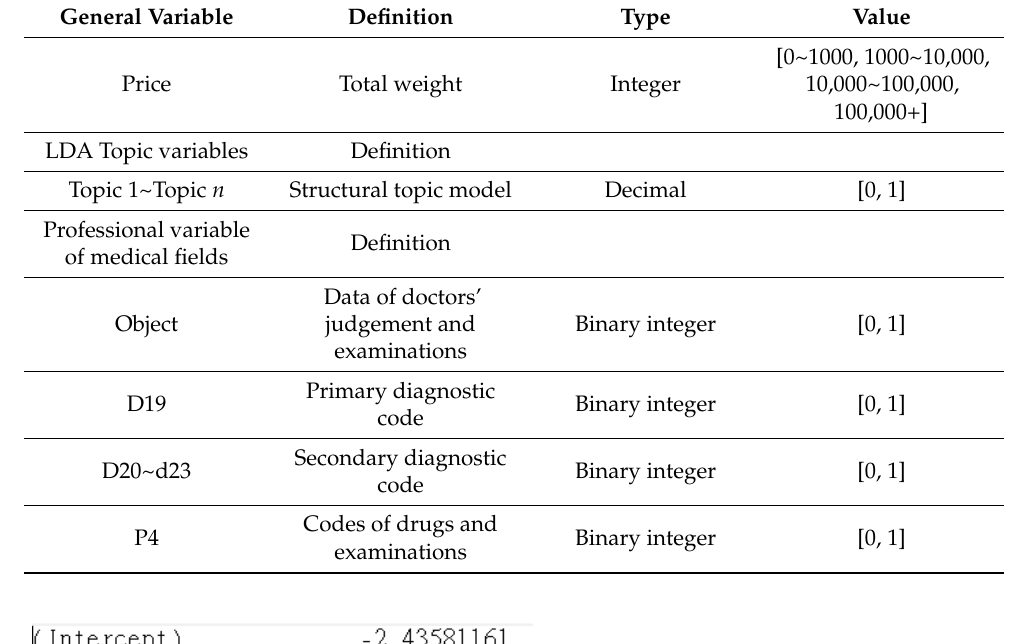
Table 2. Definition of Variables.